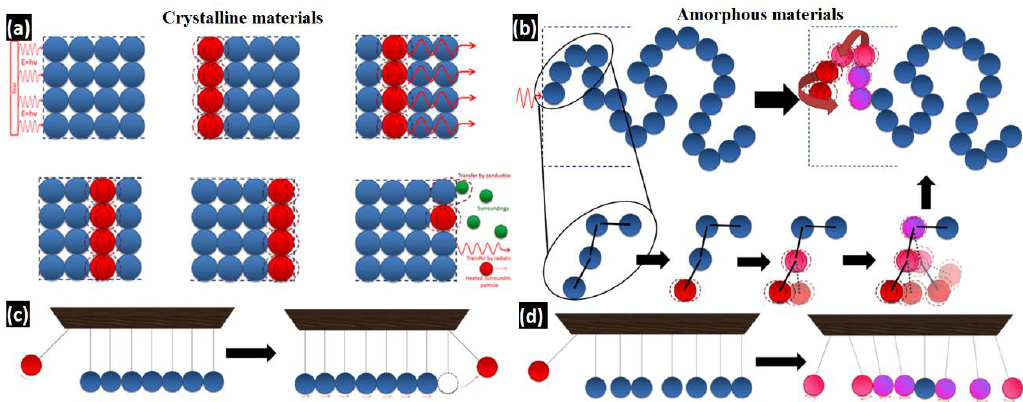
Figure 1. Heat transfer mechanism in ( a ) crystalline and ( b ) amorphous (polymer) materials; representation of difference in heat transfer mechanism of ( c ) crystalline and ( d ) amorphous (polymer) materials via Newton pendulum models (Reprinted with permission from Elsevier, Copyrights 2016) [30].